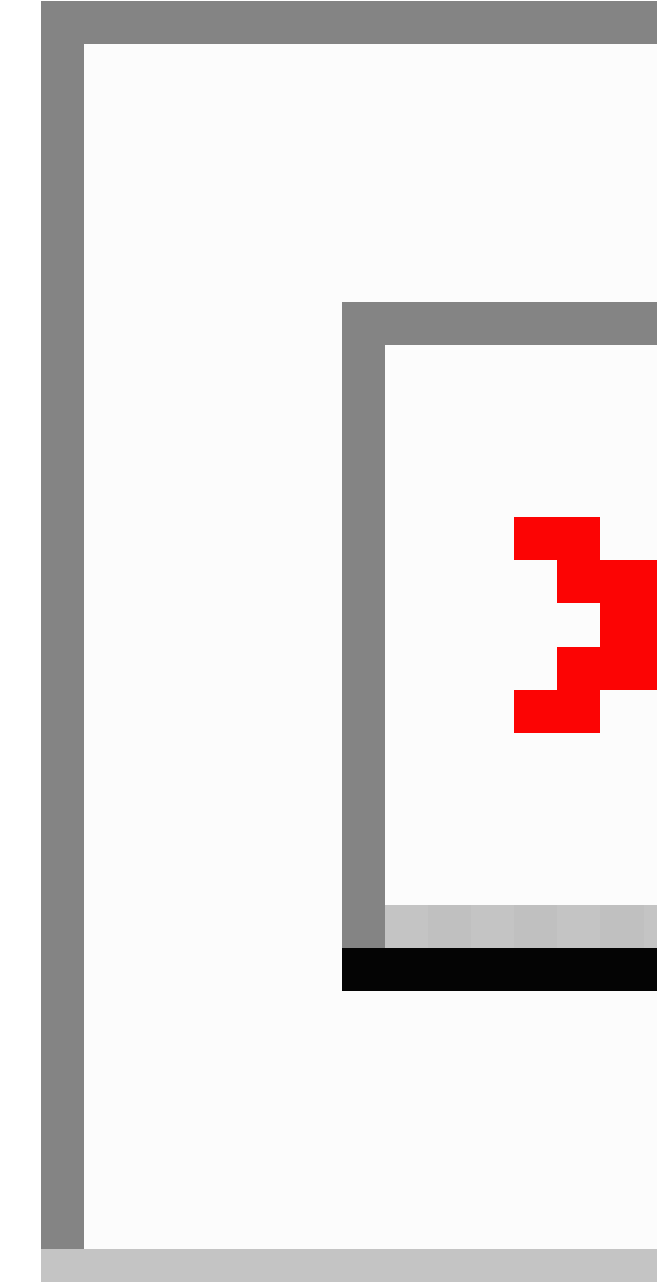
Figure 2. Simulated glucose curve used in the drawing